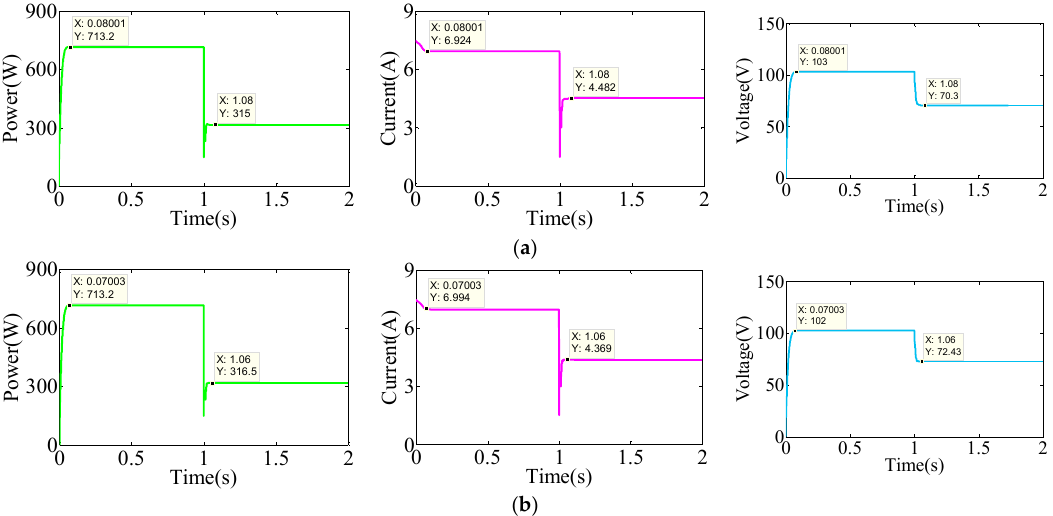
Figure 12. Power, current and voltage tracking curves of FPA and MFPA from weak shading to strong shading ( a ) FPA; ( b ) MFPA.